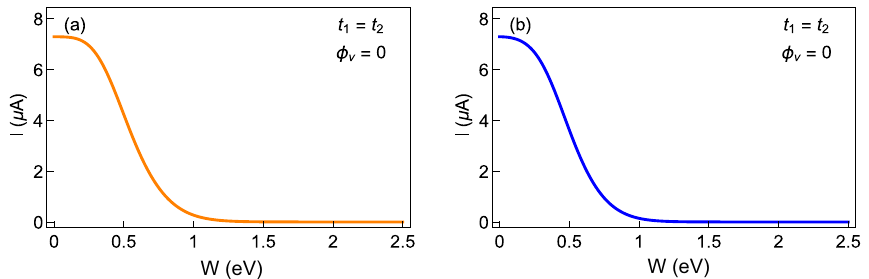
W (eV) W (eV) Figure 6. Magnitude of current, at a typical flux φ = 0.2 , with disorder strength W at half-filling for the AAH ring (in the absence of any hopping dimerization, t 1 = t 2 = 1 ) with N = 20 . Here ( a ) and ( b ) represent the non- staggered and staggered rings, respectively.